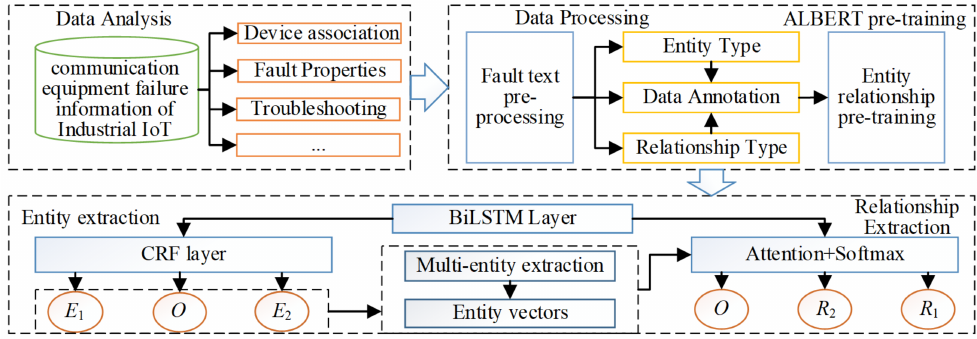
Figure 2. IIoT communication equipment fault knowledge extraction model